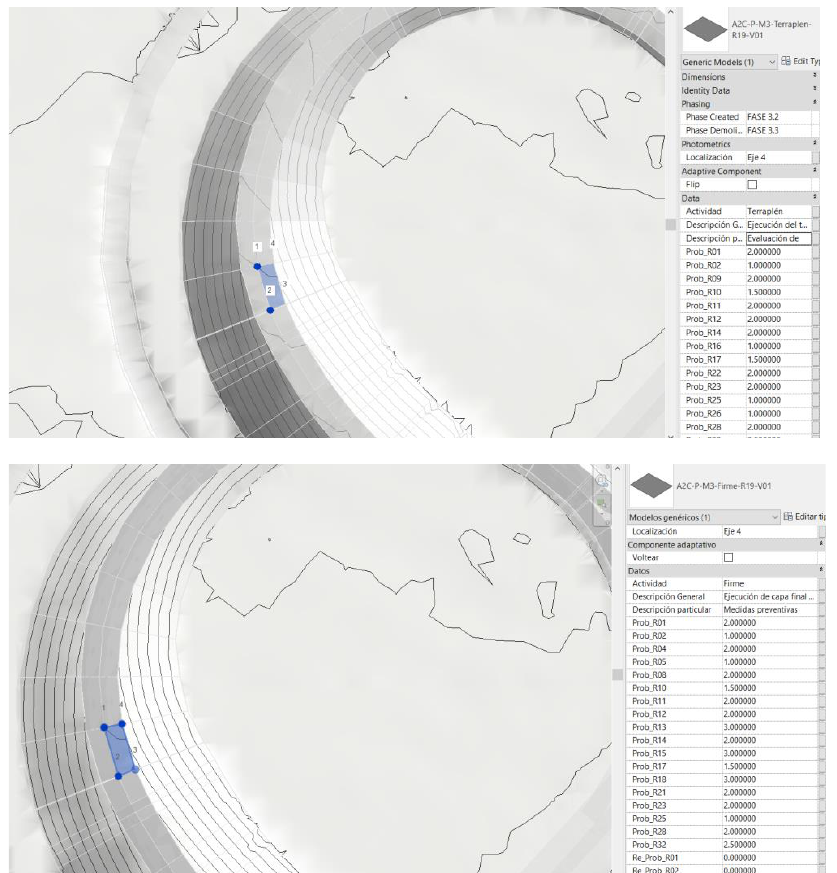
Figure 4. Revit road model with associated risk assessment information. In the image ( above ) are the risks associated with the execution of the earthworks. In the ( lower ) image are the risks associated with the execution of the pavement in the same area.